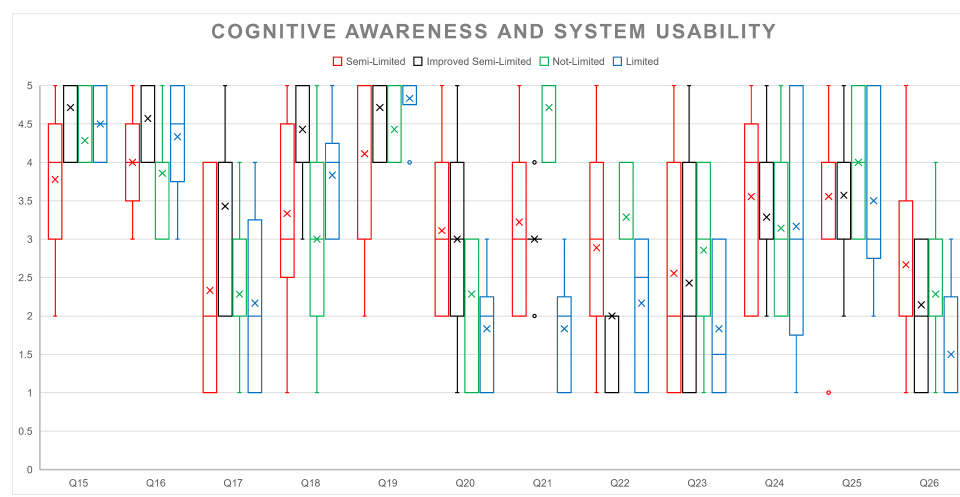
Figure 6. The box plot of the cognitive awareness and usability of following mechanism